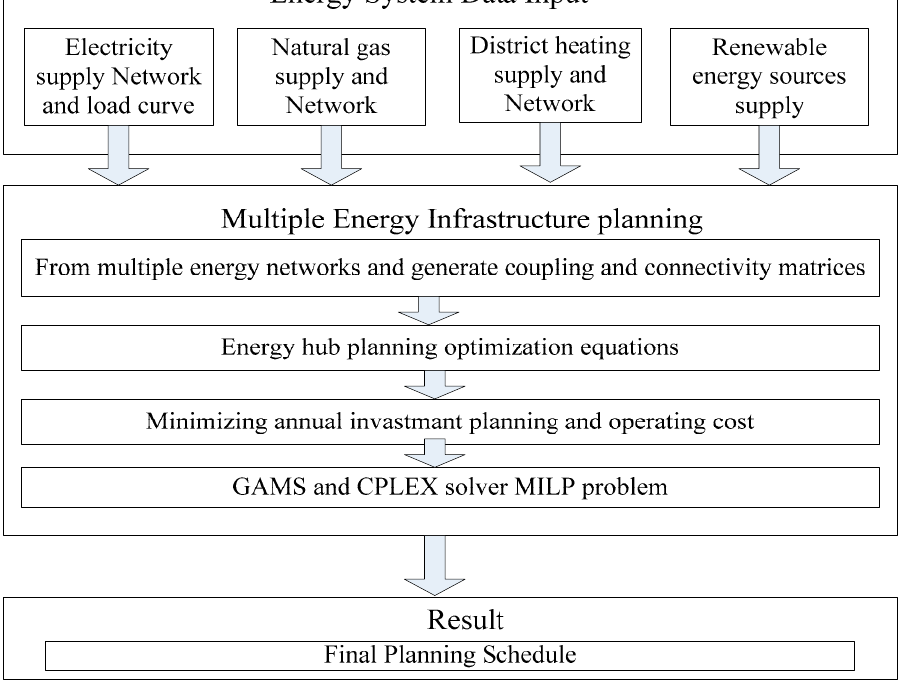
Figure 7. Flowchart for energy hub planning model .